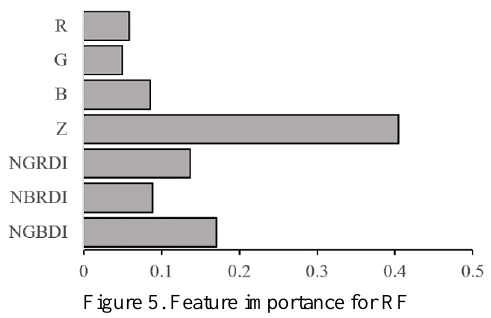
Figure 5. Feature importance for RF